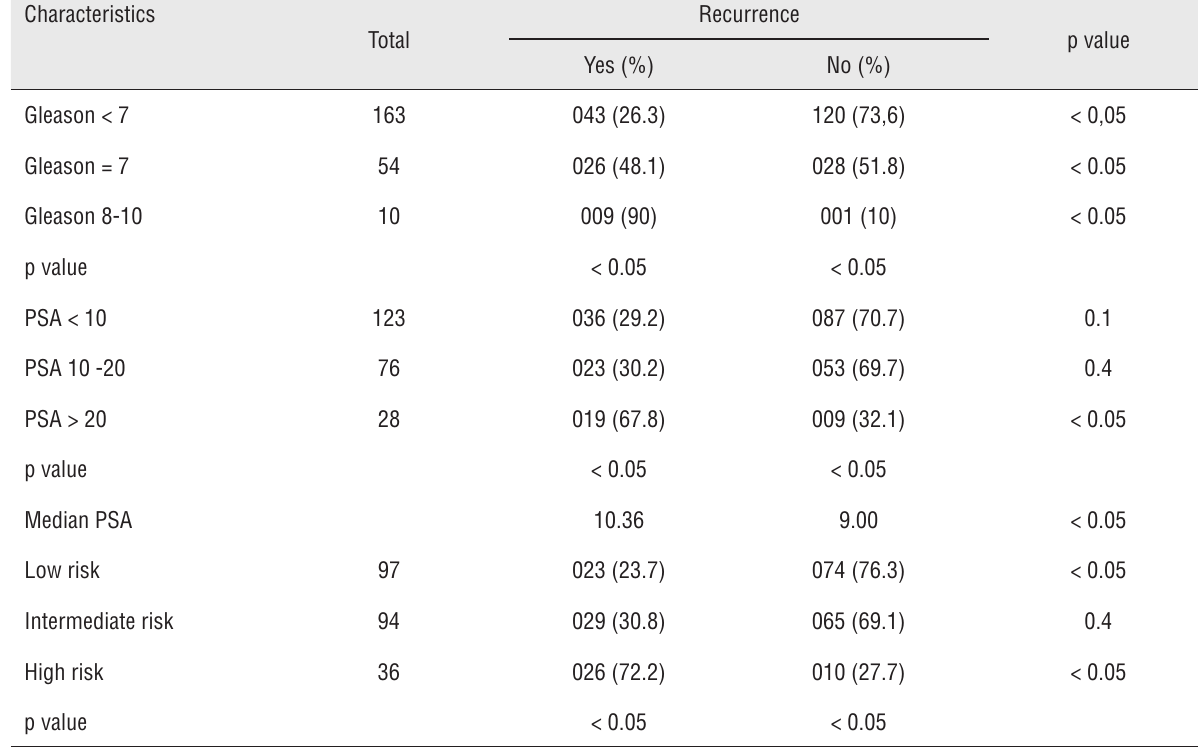
Table 5 - Biochemical recurrence after RP.